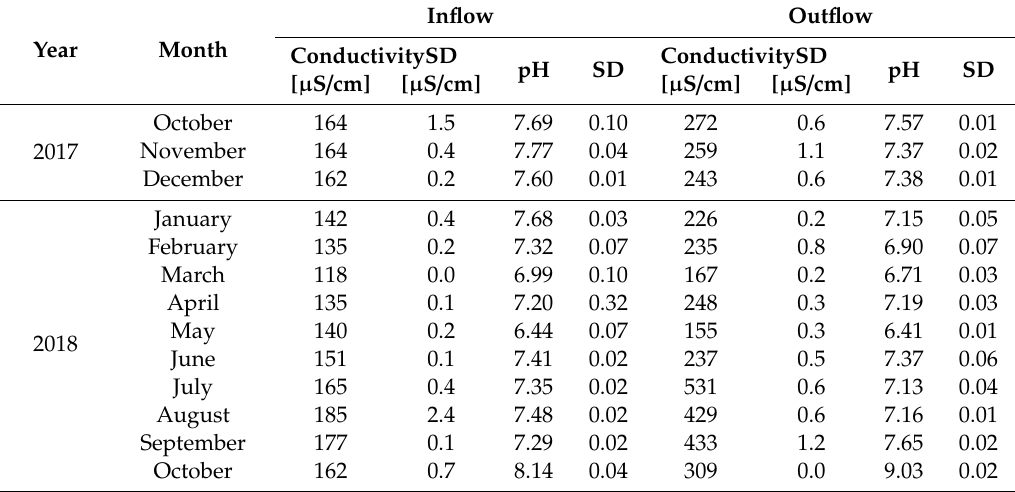
Table 10. Monitored parameters of inflow and outflow water at Site